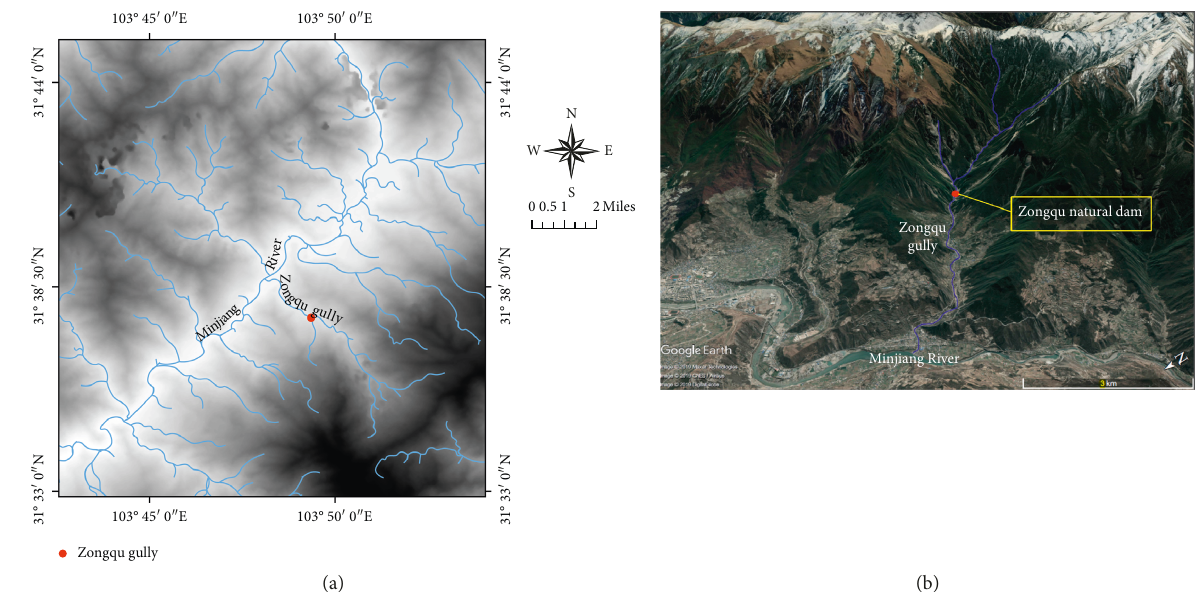
Figure 1: Location of the Zongqu gully and Zongqu natural dam. (a) Location of the Zongqu gully (b) Location of the Zongqu natural dam in the gully.